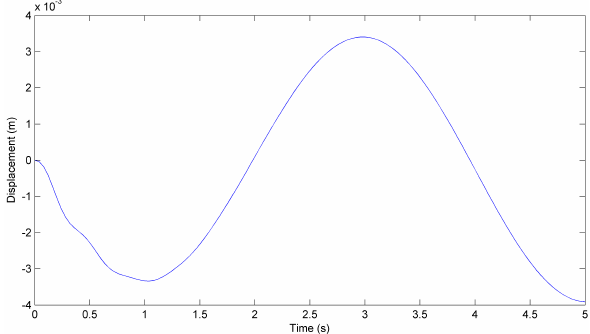
Figure 7: Forced vibration with zero initial conditions.